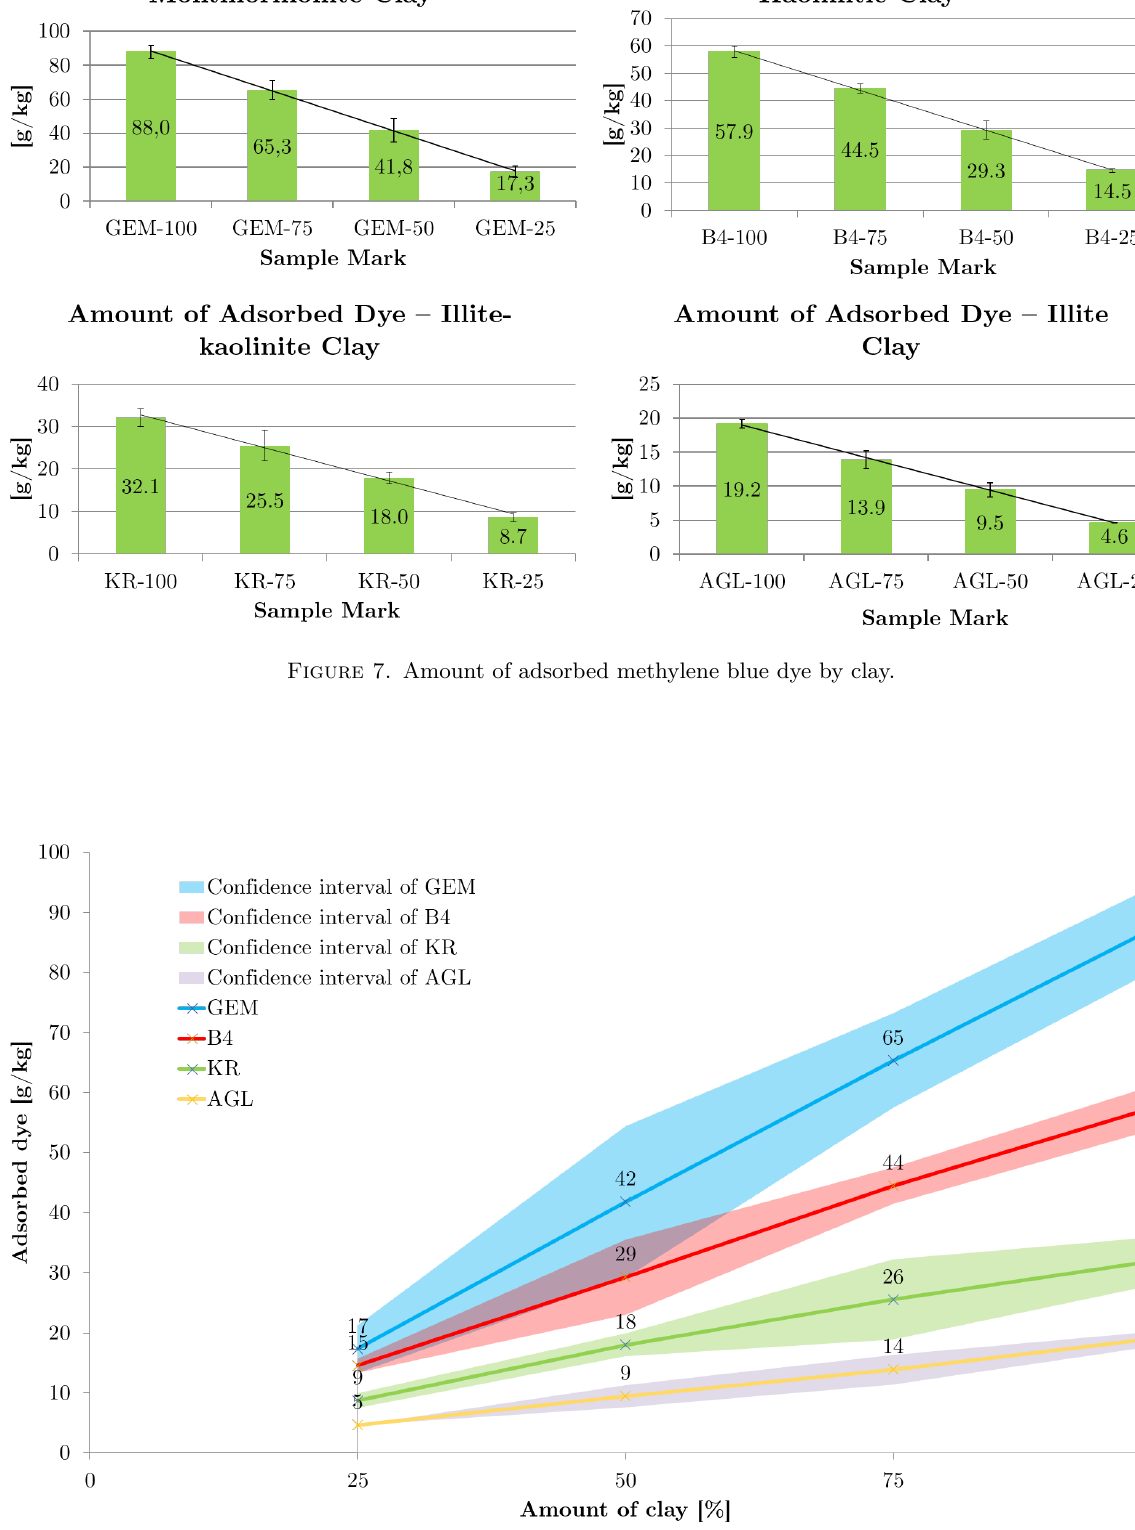
Figure 8. Confidence intervals of